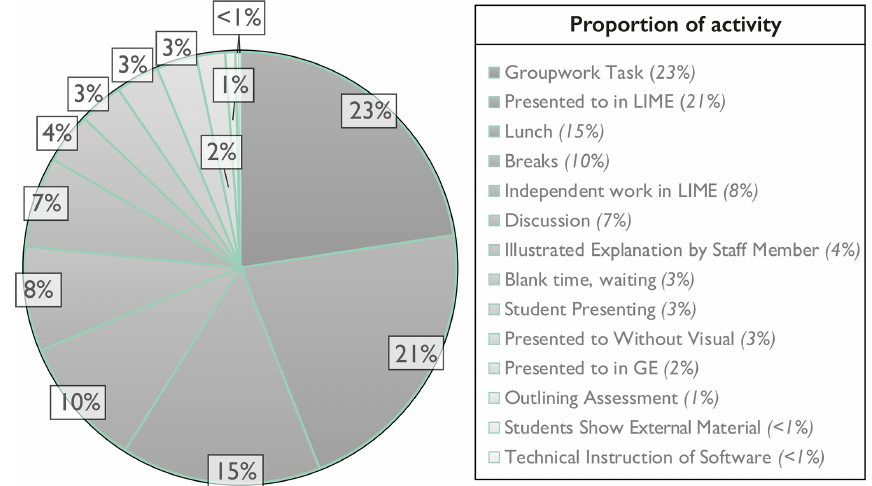
Figure 9. Duration analysis of activities across the Utah 2021 VFT; average of time spent each day on identified activities is listed in the